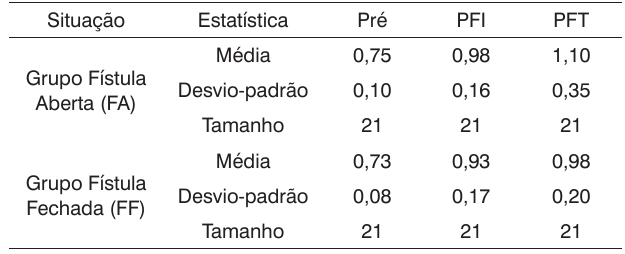
diferentes momentos do estudo.